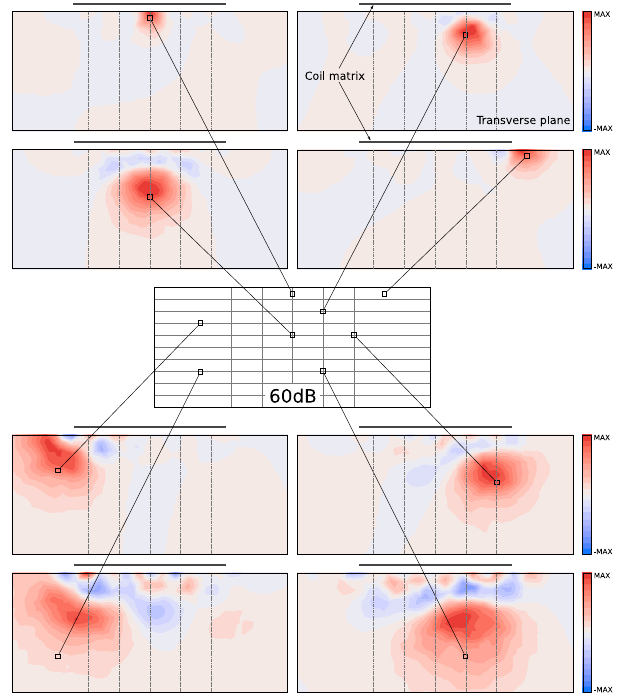
Fig.5: The PSFs of several locations corresponding to the SNR level of 60